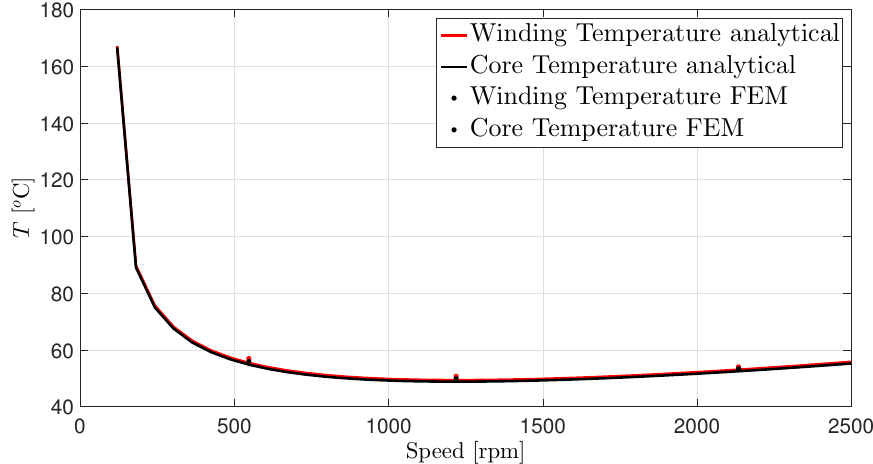
Figure 13. The winding and the core temperature variation with the